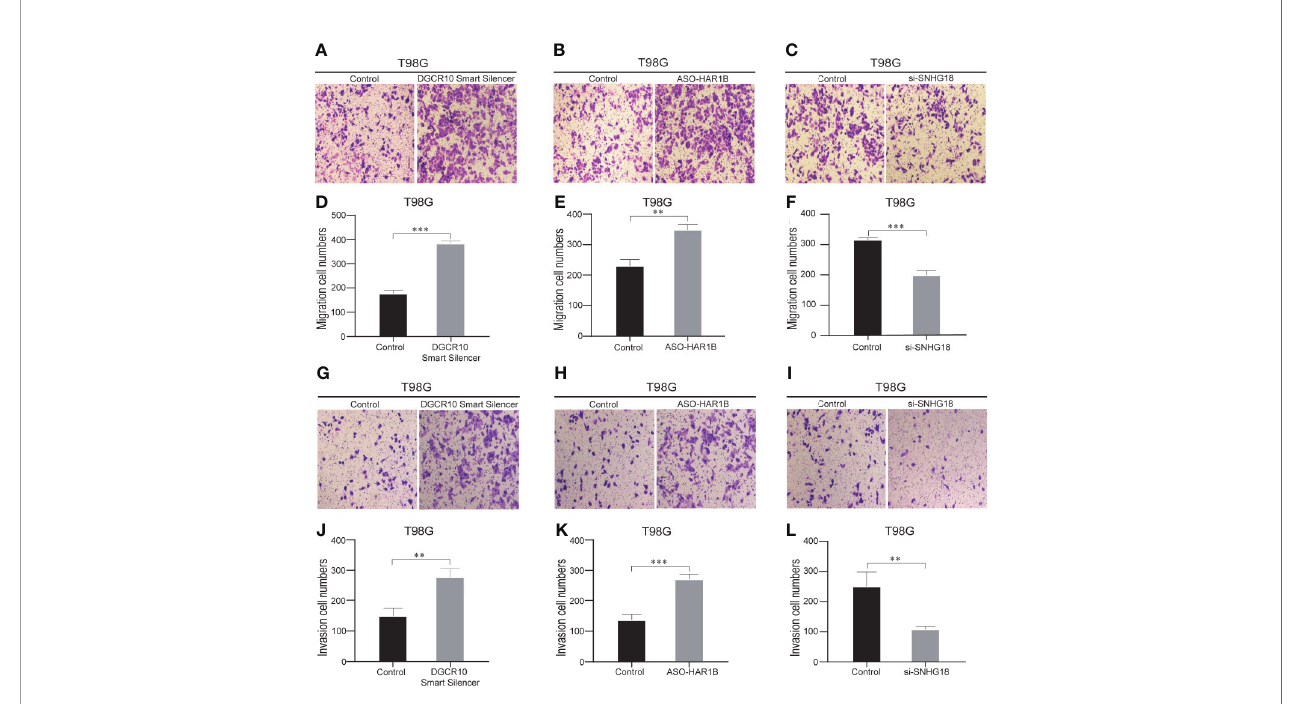
FIGURE 10 | Knockdown of DGCR10, HAR1B and SNHG18 impact the T98G cell migration and invasion ability. Representative imaging (A – C) or counting (D – F) of migration assays after knockdown of DGCR10, HAR1B, and SNHG18 in T98G cell lines. Scale bar, 200 m m. Representative imaging (G – I) or counting (J – L) of invasion assays after knockdown of DGCR10, HAR1B, and SNHG18 in T98G cell lines. Scale bar, 200 m m; **p < 0.01; ***p < 0.001.